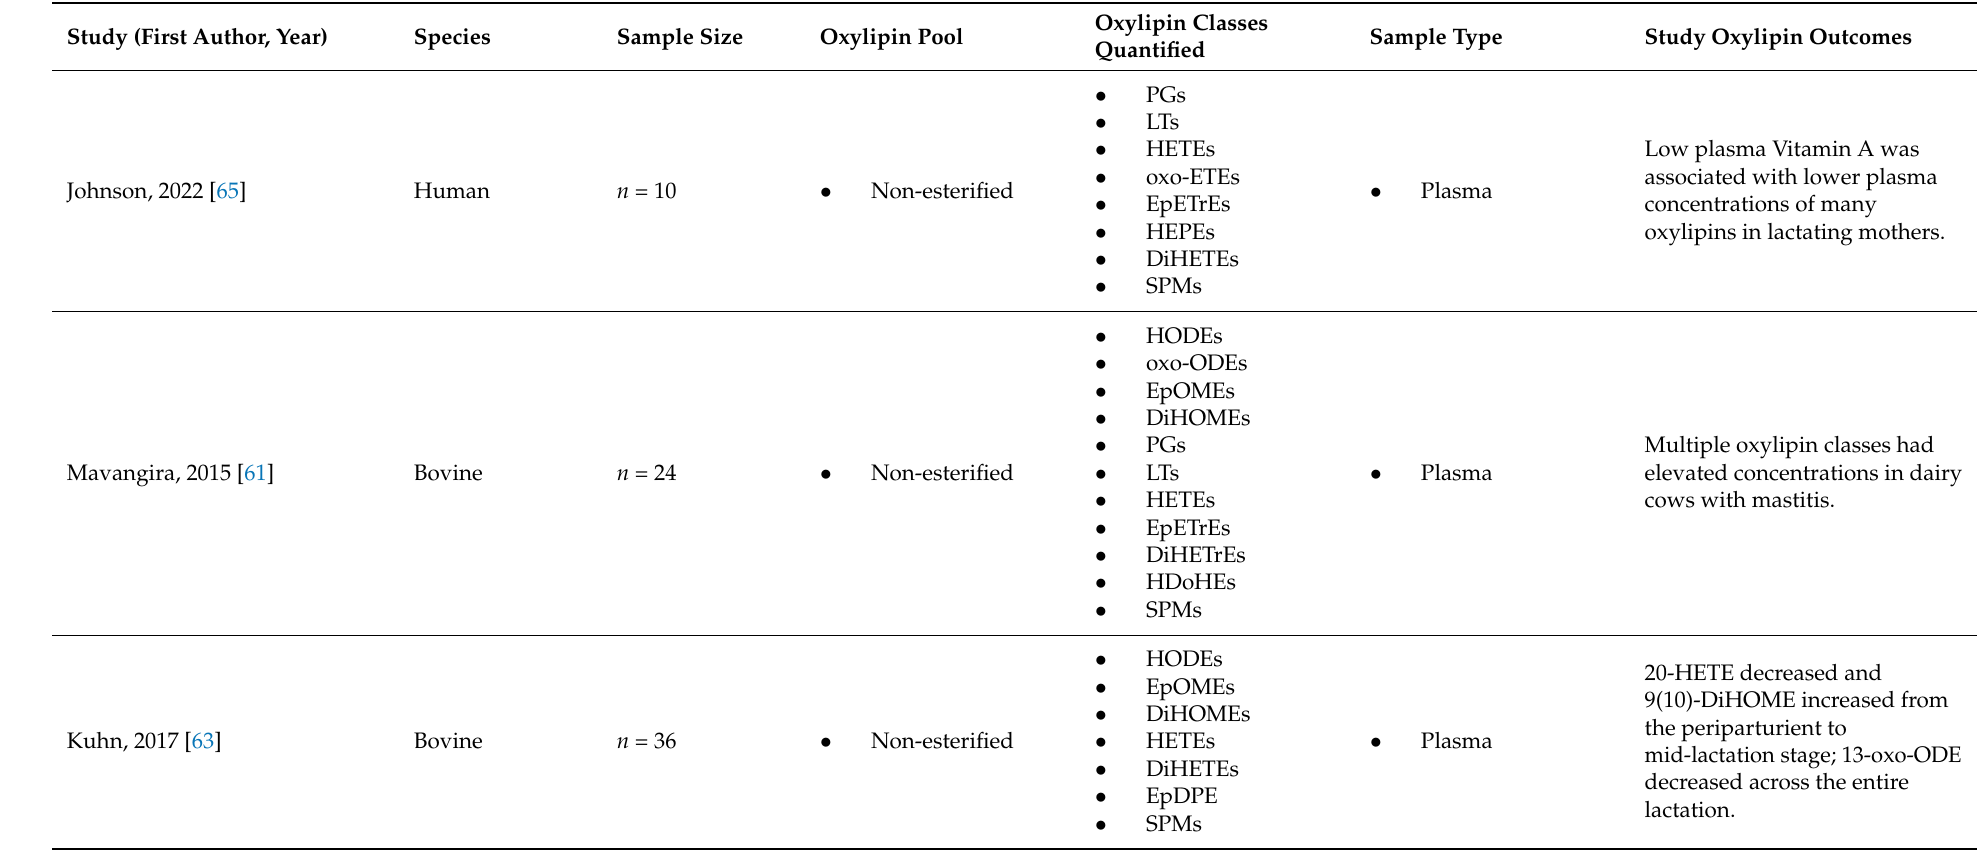
Table 3. Studies reporting lipidomic LOX and CYP450 Ep pathway oxylipin measurements in circulation during